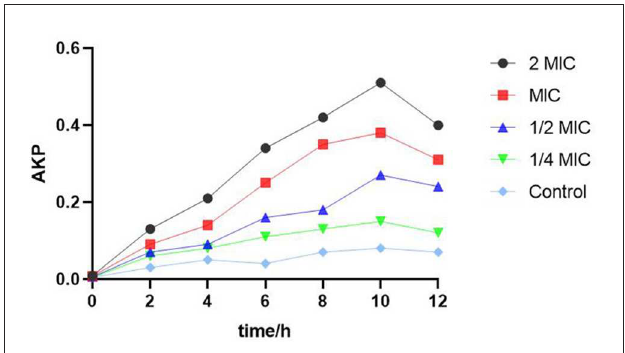
FIGURE4 The AKP content of Salmonella enteritidis treated with SEDQS.